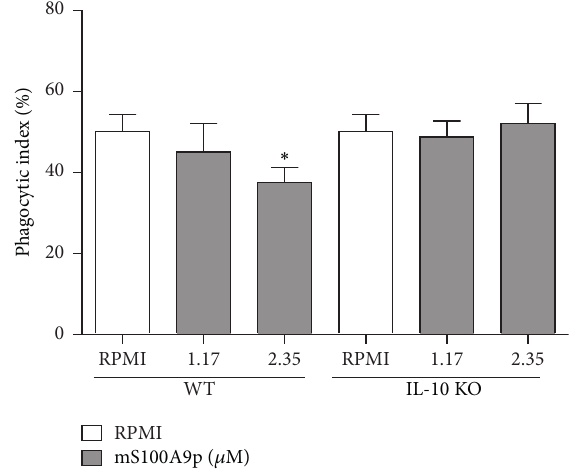
Figure 5: Phagocytic activity by peritoneal cells obtained from C57BL/6 wild-type (WT) and C57BL/6 IL-10 KO (IL-10 KO) mice after incubation with mS100A9p. Peritoneal cells obtained were adhered to coverslips (1 × 10 5 cells/well) and incubated with mS100A9p (1.17 or 2.35 𝜇 M in RPMI-1640 medium) for 1h at 37 ∘ C in 5% CO 2 . Control adherent cells were incubated only with culture medium. After this time, cells were incubated with 1 × 10 6 Candida albicans particles for 1h. Results are expressed as means ± SD, using six animals per group. ∗ 𝑃 ≤ 0.05, when compared to the control group